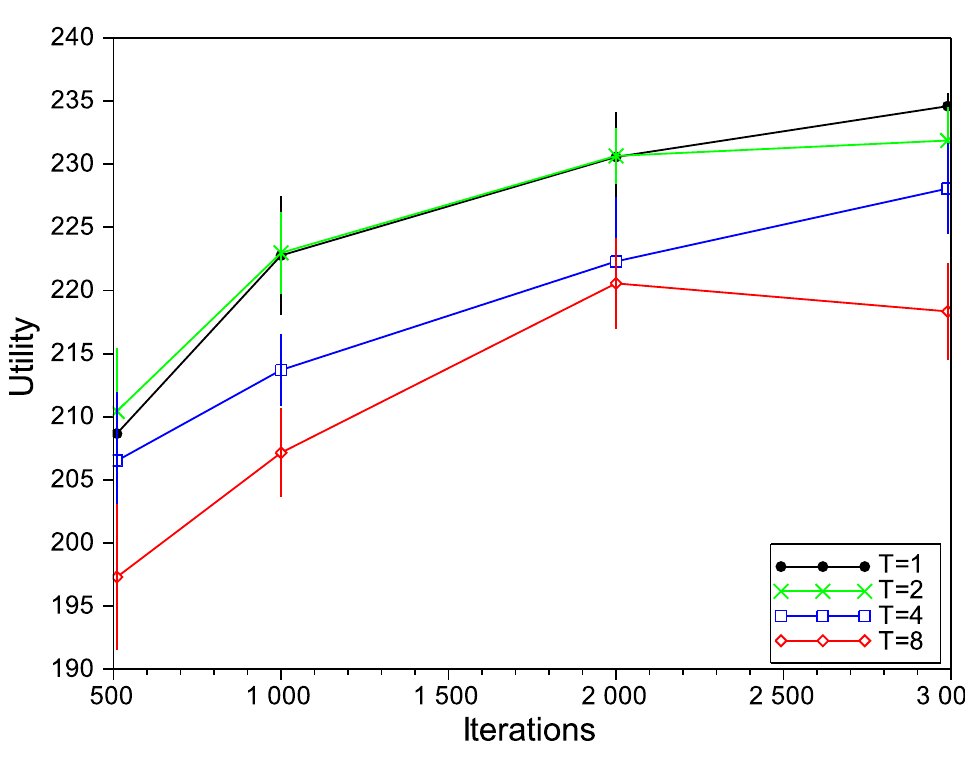
Figure 5. SA evaluation in Scenario